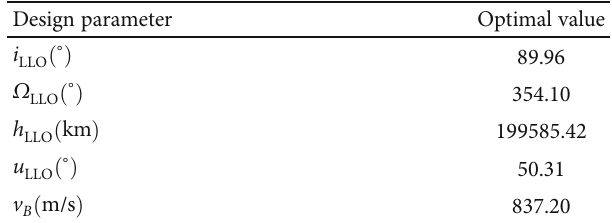
Table 3: Orbital parameters at